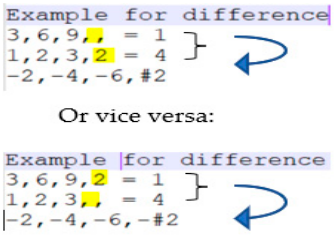
Figure 2. Handling different fields.